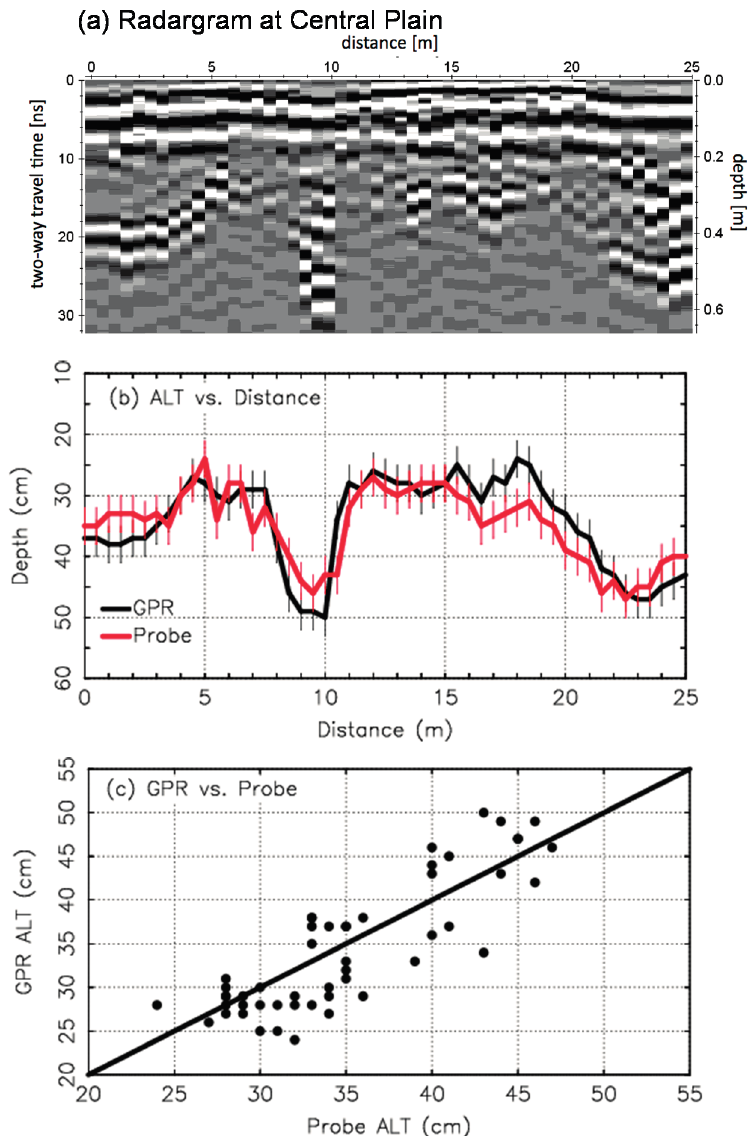
Figure 4. Radargram ( a ); GPR and probe ALT as a function of distance ( b ) and a scatterplot of GPR vs. probe ALT ( c ) for a survey at the Central Plain site. The active layer deepened when the track crossed over ice wedges at 10 and 23